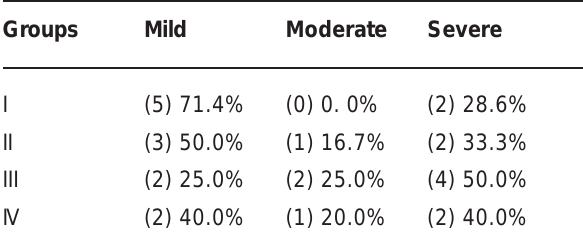
TABLE 5- Pattern of dentinal tubule infection, according to Shovelton